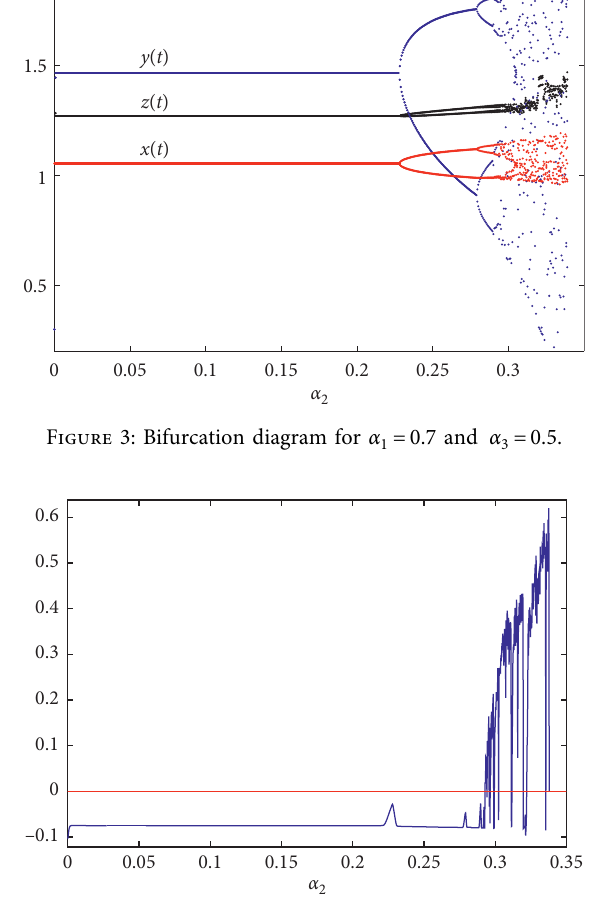
� 0.7 and α � 0.5. 1 3